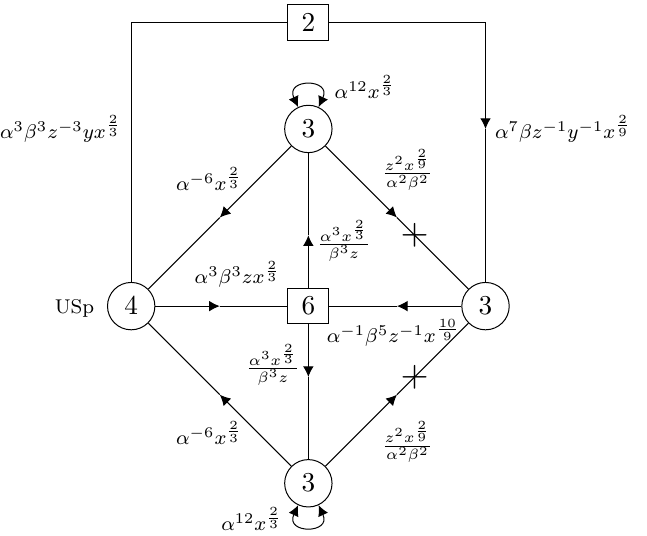
Figure 18 . The quiver for the theory resulting from the compactification of the 5 d SU(2) × SO(16) SCFT on a torus with flux 1 (1 , − 1; 3 , 3 , 1 , 1 , 1 , 1 , 1 , 1) 2